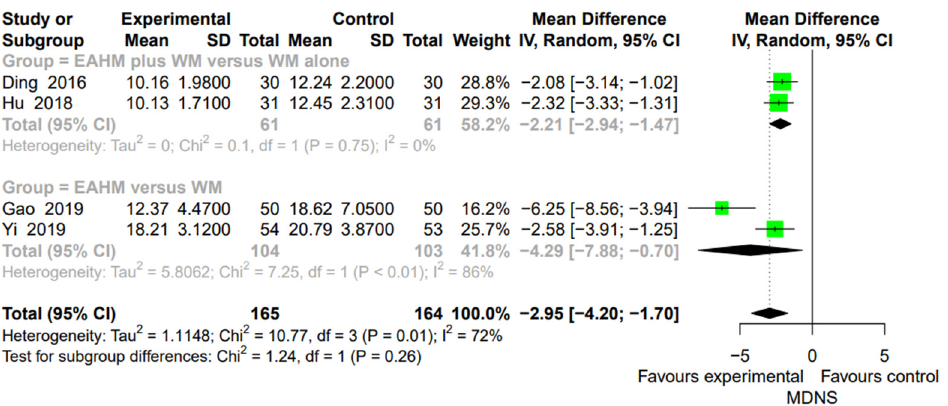
Figure 13. Forest plot of the trials reporting the effect of East Asian herbal medicine monotherapy on the Michigan diabetic neuropathy score (MDNS) for peripheral neuropathy.